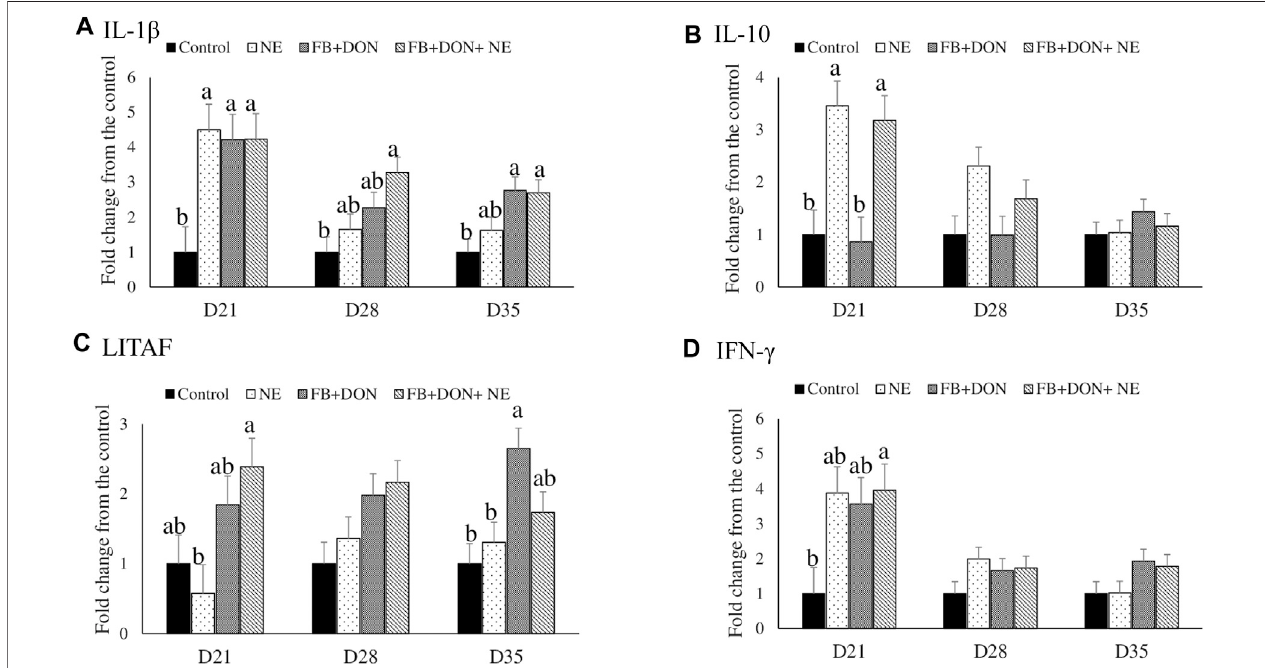
FIGURE 4 | Effect of subclinical dose of FB + DON and E. maxima/C. perfringens challenge on cecal tonsil cytokine mRNA expression. Day-old chicks were distributedintofourtreatmentgroups:control,necroticenteritis(NE),fumonisin+deoxynivalenol(FB+DON),andFB+DON+NEgroups.BirdsintheNEandFB+DON + NE groups received 2.5 ×10 3 Eimeria maxima oocystper bird onday 14.All birds received 1 ×10 8 CFU/birdof Clostridium perfringens on days 19,20, and 21. IL-1 β , IL-10, LITAF, and IFN- γ mRNA content was analyzed after correcting for the housekeeping gene RPS13 mRNA content and normalizing to the mRNA content of thecontrolgroup,soallbarsrepresentfoldchangecomparedtothecontrolgroup.Bars(+SEM)withoutacommonsuperscriptdiffersigni fi cantly( p < 0.05). n =8(8pens of 15